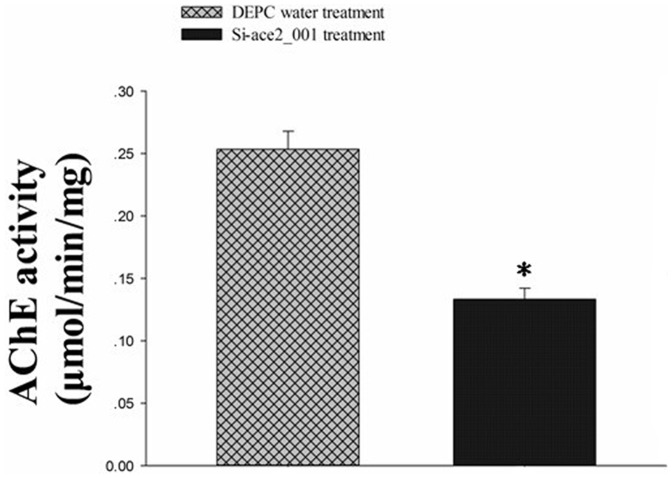
Activity of AChE from Plutella xylostella larvae treated by Si-ace2_001 or DEPC water.Each point represents the mean ±SEM from three independent experiments and asterisk means significant differences (P<0.05) between the two groups.